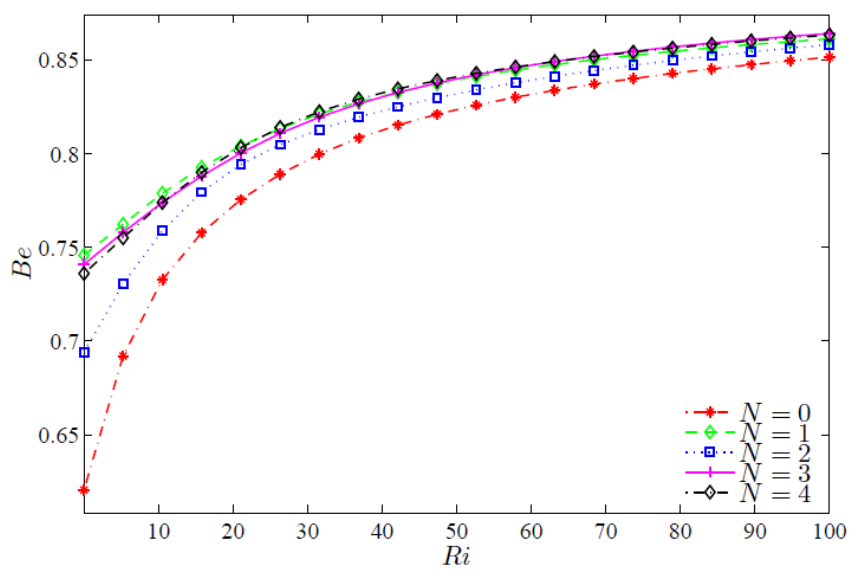
Figure 8. Be vs. (cid:1844)(cid:1861) for different (cid:1840) at (cid:2038) = 0.02 . Figure 9 plots (cid:1840)(cid:1873)(cid:3364)(cid:3364)(cid:3364)(cid:3364) against Ri at (cid:1840) = 3 and different values of (cid:2038) . Due to the increase